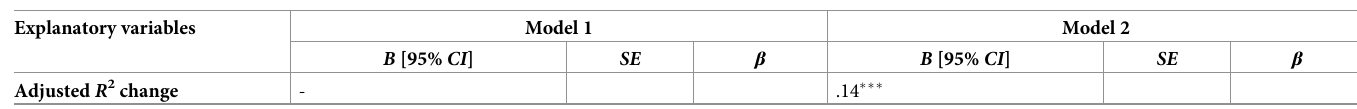
(Table 4). Nonmodifiable factors jointly accounted for 20% of the variances in the depression scores, with age, education, divisions and living place, current job, and marital status emerging as significant predictors (Model 1). When modifiable predictors were added to the multivari- able model for depression, the model’s explanatory power increased to 41%. Modifiable pre- dictors caused an additional 21% of the variances in the depression scores. Having a secondary